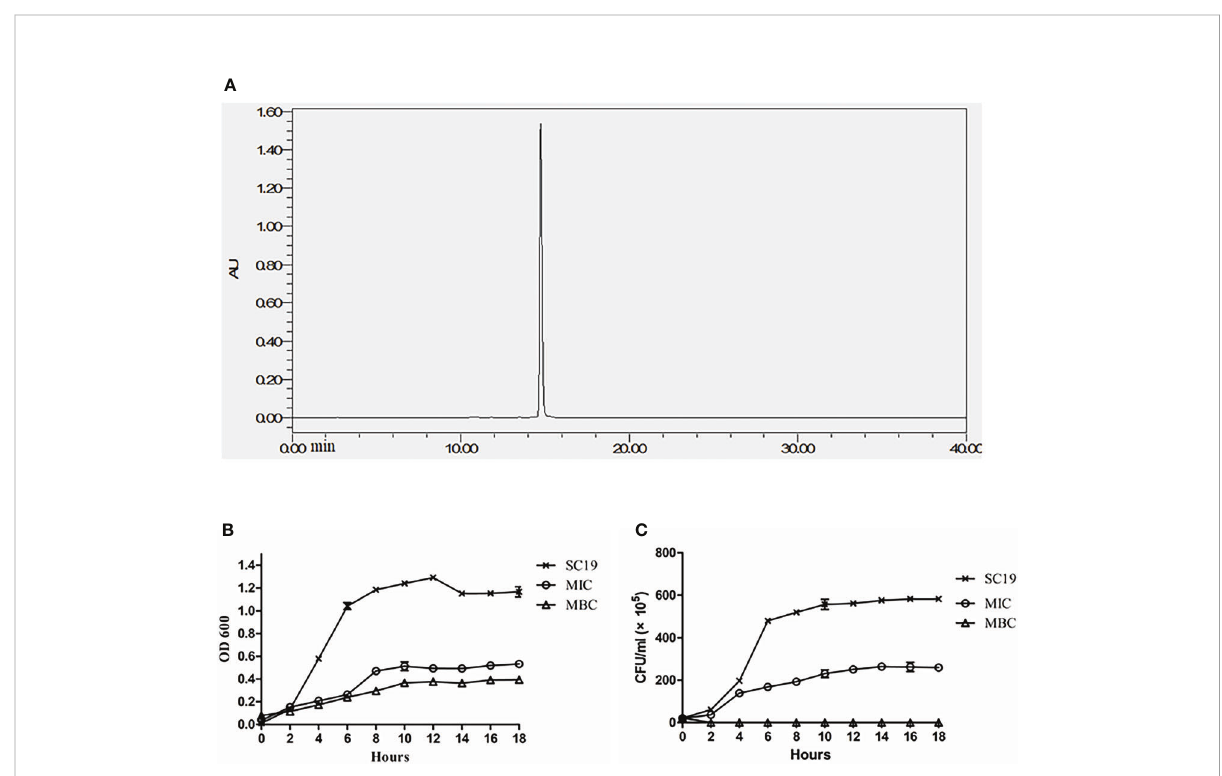
FIGURE 1 EGCG extract quanti fi cation and effect of EGCG on SC19 growth (A) The EGCG extract was quantitatively determined by HPLC, The purity of EGCG reached 99.99%. (B) Kinetics of the killing effect of EGCG on SC19. The concentrations of EGCG ranged from MIC to MBC. Bacterial viability were monitored by CFU counts at the indicated times. (C) OD 600 of SC19 in the absence of EGCG and in the presence of EGCG at MIC and